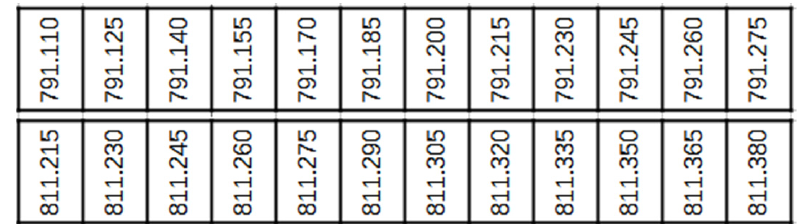
Figure 11. Subcarriers of NB-IoT signals of other network operators.